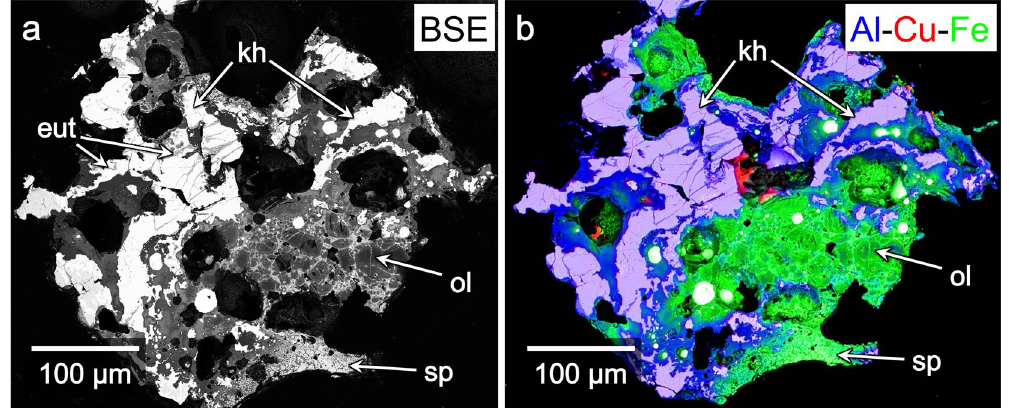
Figure 1. Overview of Khatyrka Grain 126A. ( a ) Backscattered electron (BSE) image of Grain 126A. Bright regions are mostly Al-Cu-Fe metal assemblages; they have an irregular, cuspate-lobate appearance and consist predominantly of khatyrkite (“kh”), stolperite, and eutectoid regions (“eut”; further detail in Fig. 3) that contain a vermicular mixture of metallic Al (up to 13.3 weight% Cu) and khatyrkite. The darker regions mostly comprise crystals of olivine (“ol”; further detail in Fig. 2c and d) and spinel-group minerals with varying composition, which we call “spinel” (“sp”; further detail in Fig. 6)—all surrounded by silicate glass. ( b ) Al- Cu-Fe combined X-ray area map, overlaid on a BSE image. Light purple regions are Al-Cu metal (khatyrkite, stolperite); blue/dark purple regions are predominantly glass and spinel; green regions are mainly the silicate glass and crystals that grew within the melt (olivine, spinel); the relatively large white grains are predominantly Fe-Ni (appearing white because of the underlying BSE image, despite containing Fe). The different compositions of spinel manifest here as different degrees of brightness ( a ) and different colors ( b